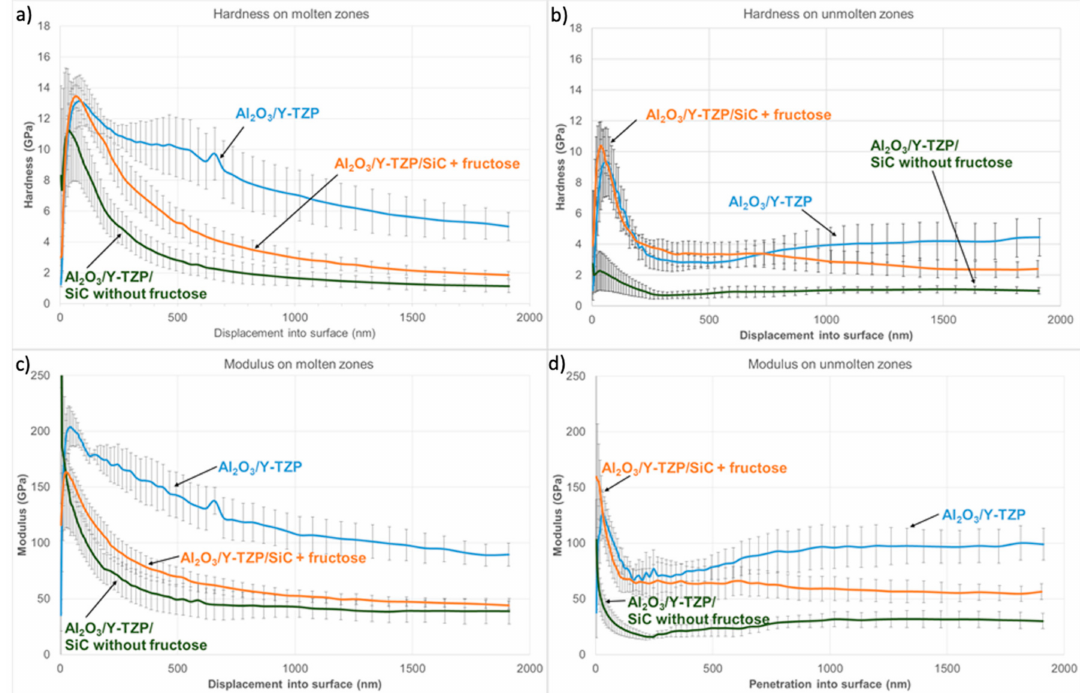
Figure 7. Hardness and modulus at different penetration depths of different samples: ( a , c ) on molten zones; ( b , d ) on unmolten zones.